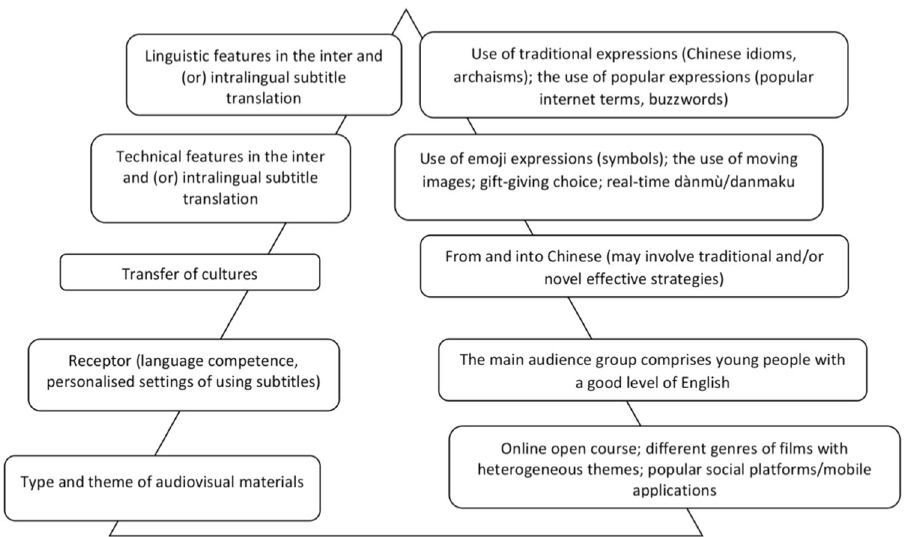
Fig. 1 The connection between each factor and its counterparts in the polysystem in the case of designing an AI-driven subtitling course. This fi gure alters Jin ’ s (2018, p. 81) diagram pinpointing the connection between fi lmic factors and their counterparts under the guidance of polysystem to demonstrate the suitability and practicality of the present research explicitly in the context of devising a novel subtitling